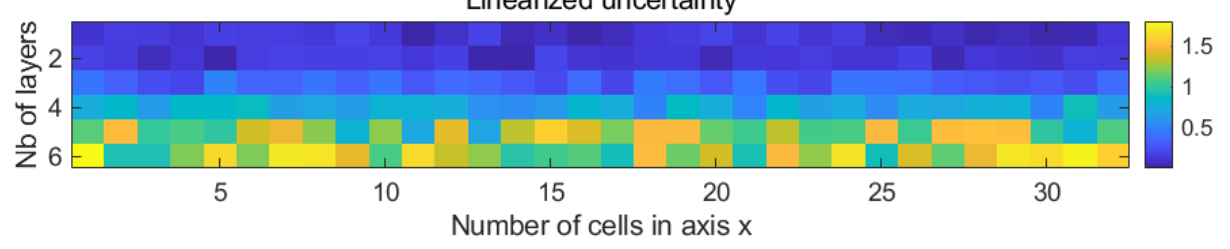
Figure 10. Linear uncertainty (in log scale) derived from the Jacobian matrix using the posterior covariance matrix.